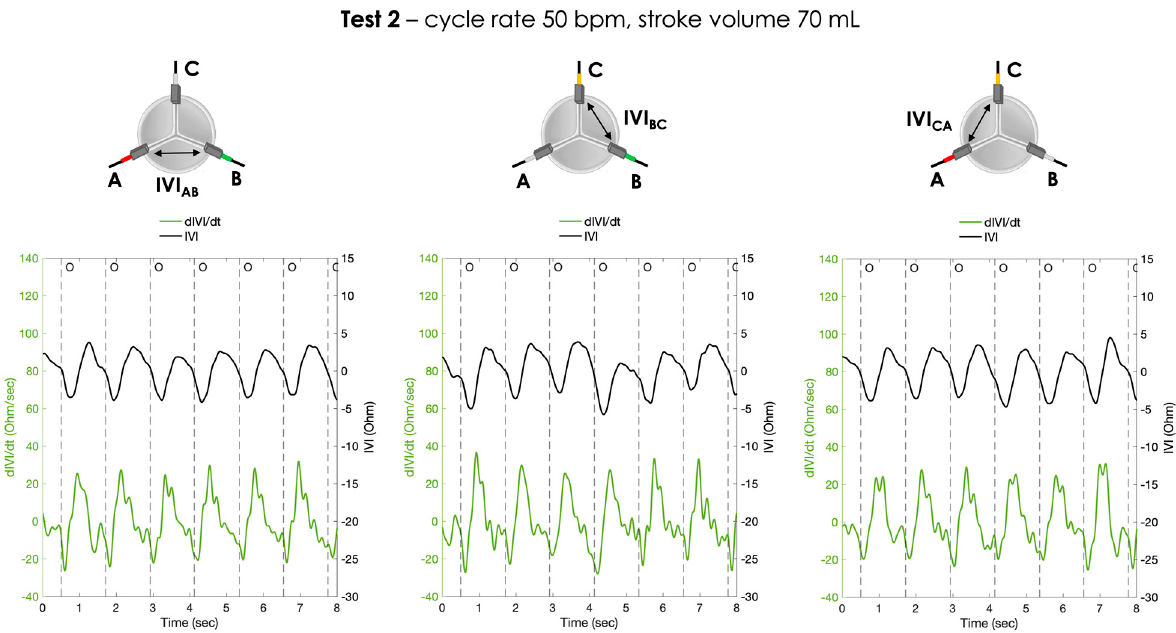
Figure 10. The IVI signal (black line) and the corresponding first derivative dIVI/dt (green line) obtained for the three pairs of electrodes during Test 2 (cycle rate 50 bpm, stroke volume 70 mL). AB ( left ), BC ( center ) and CA ( right ). O = start of valve opening identified with the low peak of the aortic pressure.